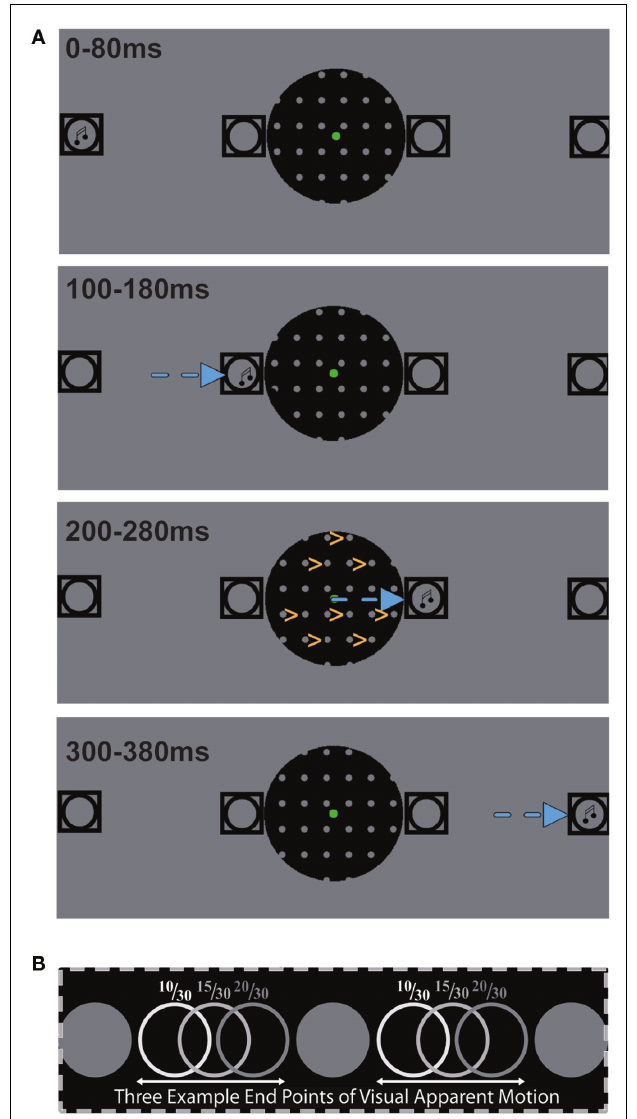
FIGURE 1 | (A) A schematic depiction of the stimuli employed in this study illustrating a rightward auditory motion trial during which the participant perceived rightward visual apparent motion. Squares depict the four speaker locations and the musical note symbols represent the location at which a sound is being presented.The direction of auditory apparent motion is depicted by the blue arrows and the direction of visual apparent motion by yellow arrows. (B) An illustration of three possible endpoints of visual apparent motion whose position is expressed as the distance from the nearest left starting point divided by the inter-column distance.The 10/30 endpoints most likely induce rightward visual apparent motion and the 20/30 endpoints most likely induce leftward visual apparent motion while the 15/30 endpoints are as likely to induce left as rightward visual apparent